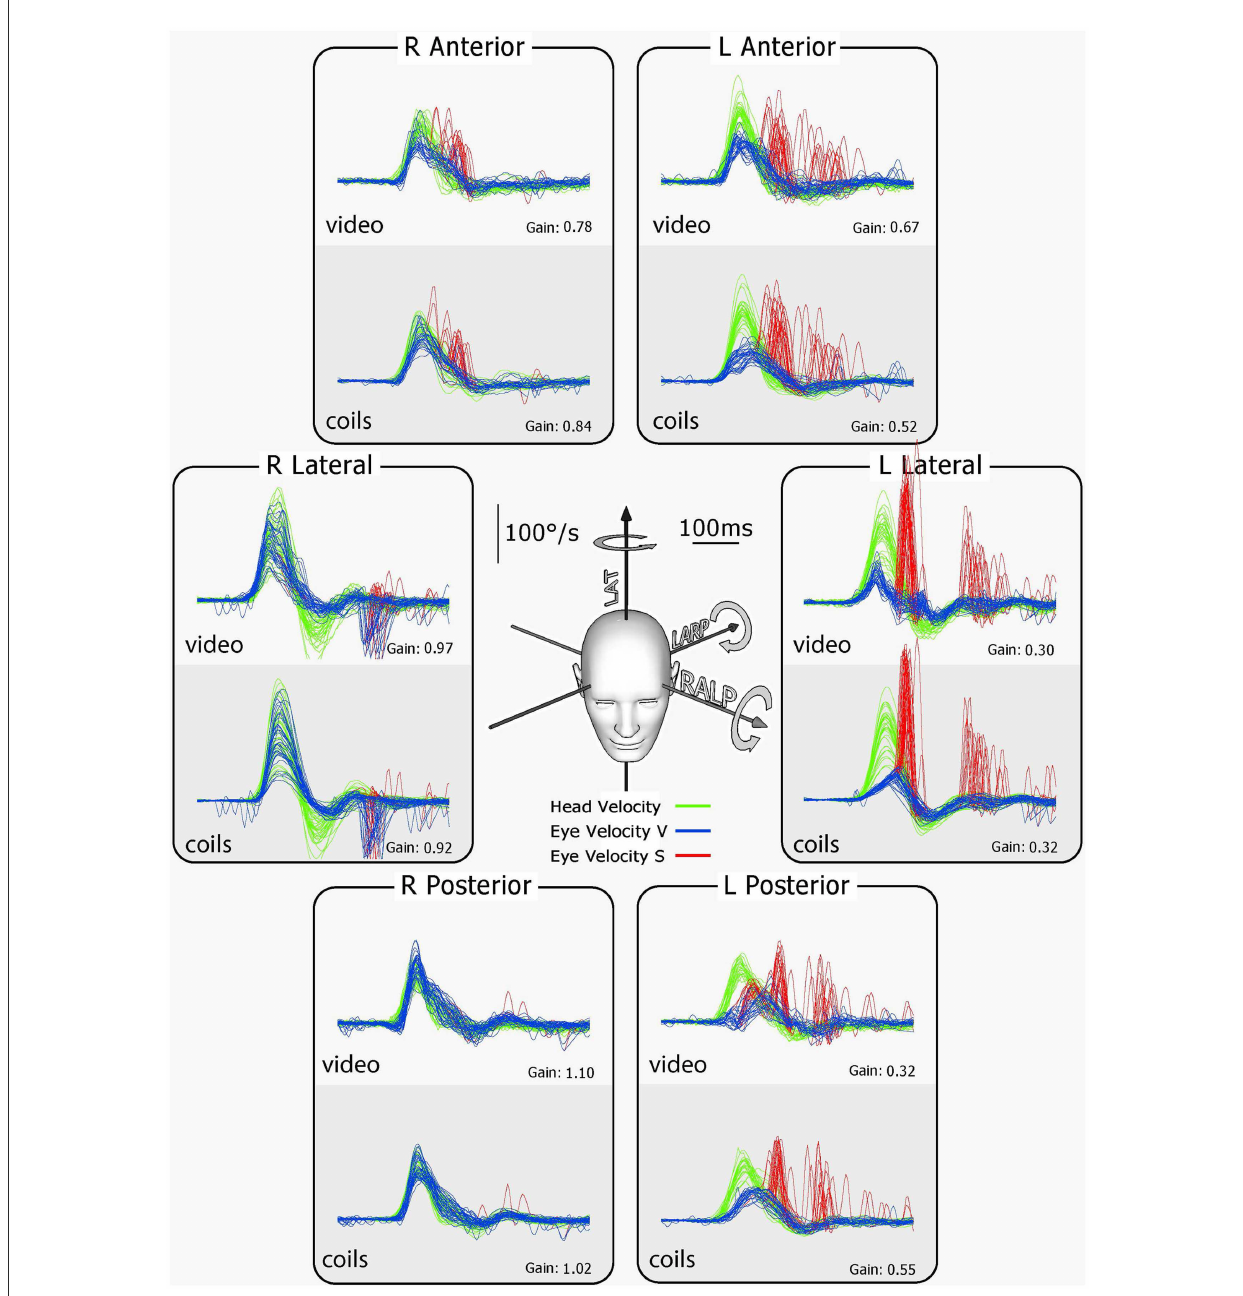
FIGURE13 Results for tests of every semicircular canal of a patient with left unilateral vestibular loss. The patient’s eye was measured simultaneously with scleral search coils and vHIT. For every rotation direction activating the canals on the healthy right side, the eye velocity response is close to normal. However, for every rotation in a direction to activate canals on the affected left side, there is a reduced VOR response. In particular, for the vertical canals on the affected side, there is clearly reduced function. To compensate for the deficit on the affected left side, overt saccades appear after head rotation (red traces). These corrective saccades are important confirmation that the reduced VOR gain is not due to poor gaze direction. The late inverted overt saccades for right lateral stimulation are likely due to the fact that there was such a big overshoot in head velocity that the overshoot became an impulse to the affected left side, which the affected ear could not generate sufficient SPV to compensate, so the “reverse” overt saccades appeared. There is very close similarity between coils and vHIT traces, further validating vHIT [Reproduced with permission from MacDougall et al.